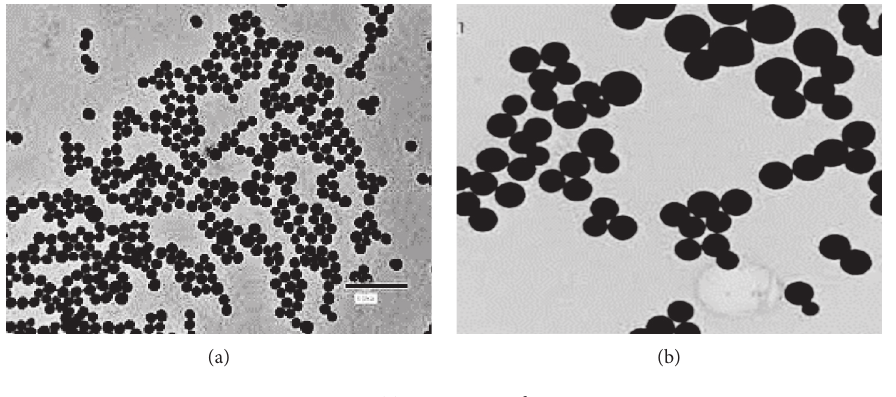
Figure 7: TEM images of